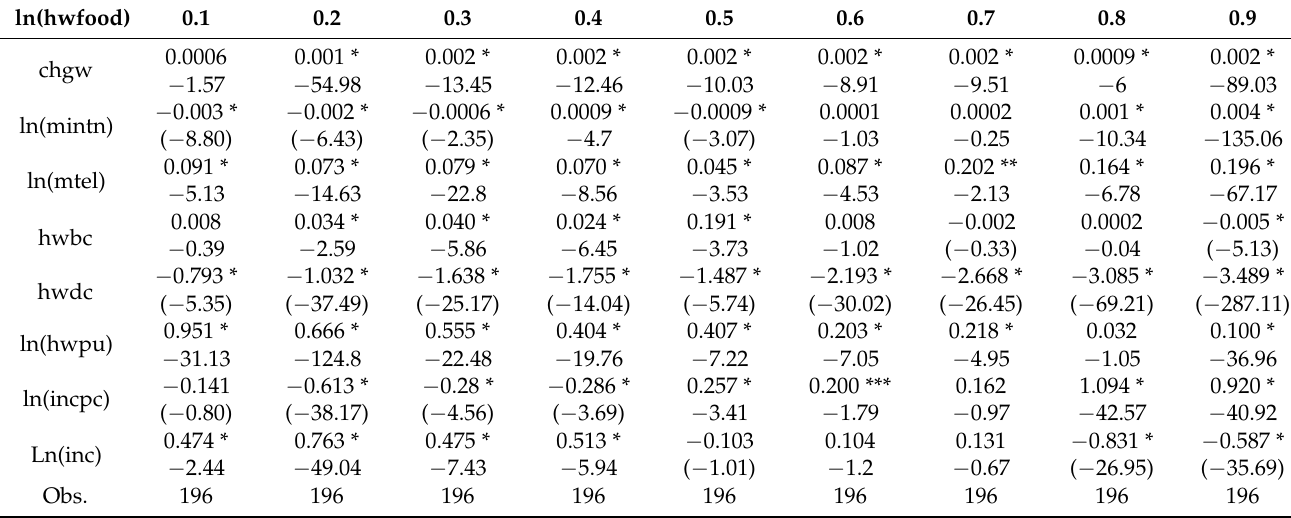
Table 4. Effects of trends, digital technology, and market concentration on health and wellness food